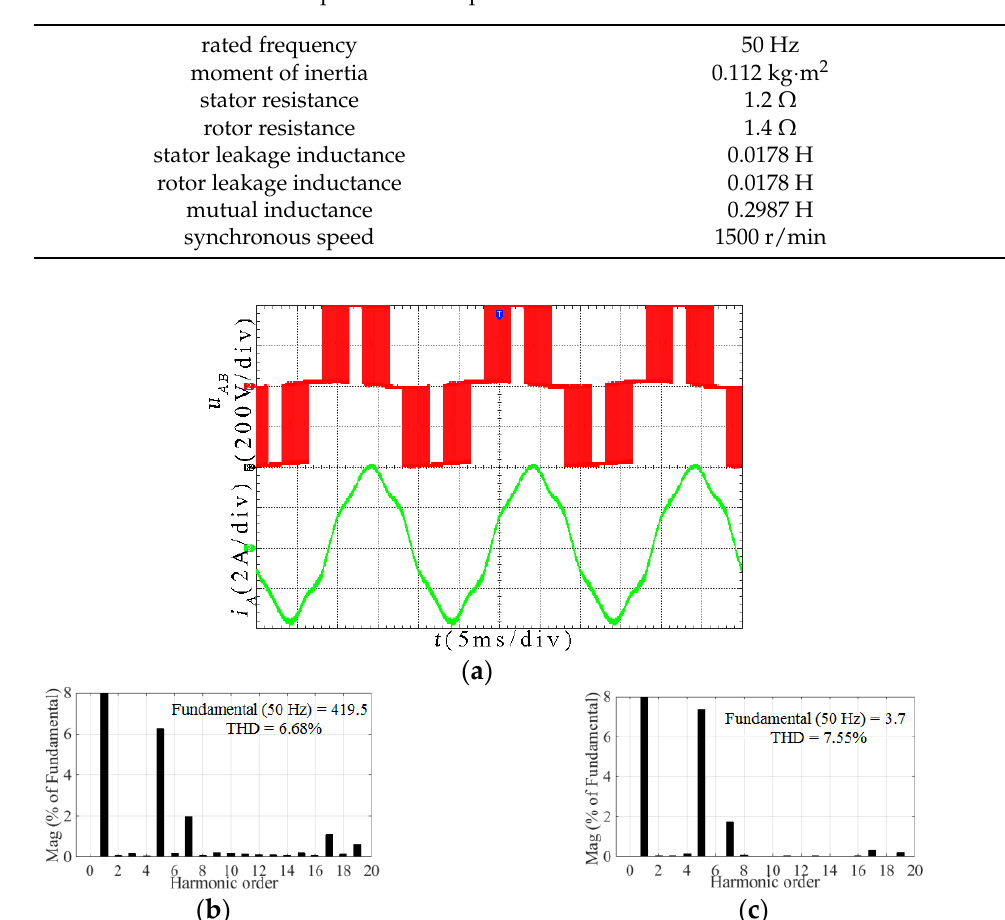
Figure 13. Experimental results for the TFOS at m = 0.605: ( a ) Line voltage u AB and line current i A ; ( b ) Spectrum analysis for u AB ; ( c ) Spectrum analysis for i A .